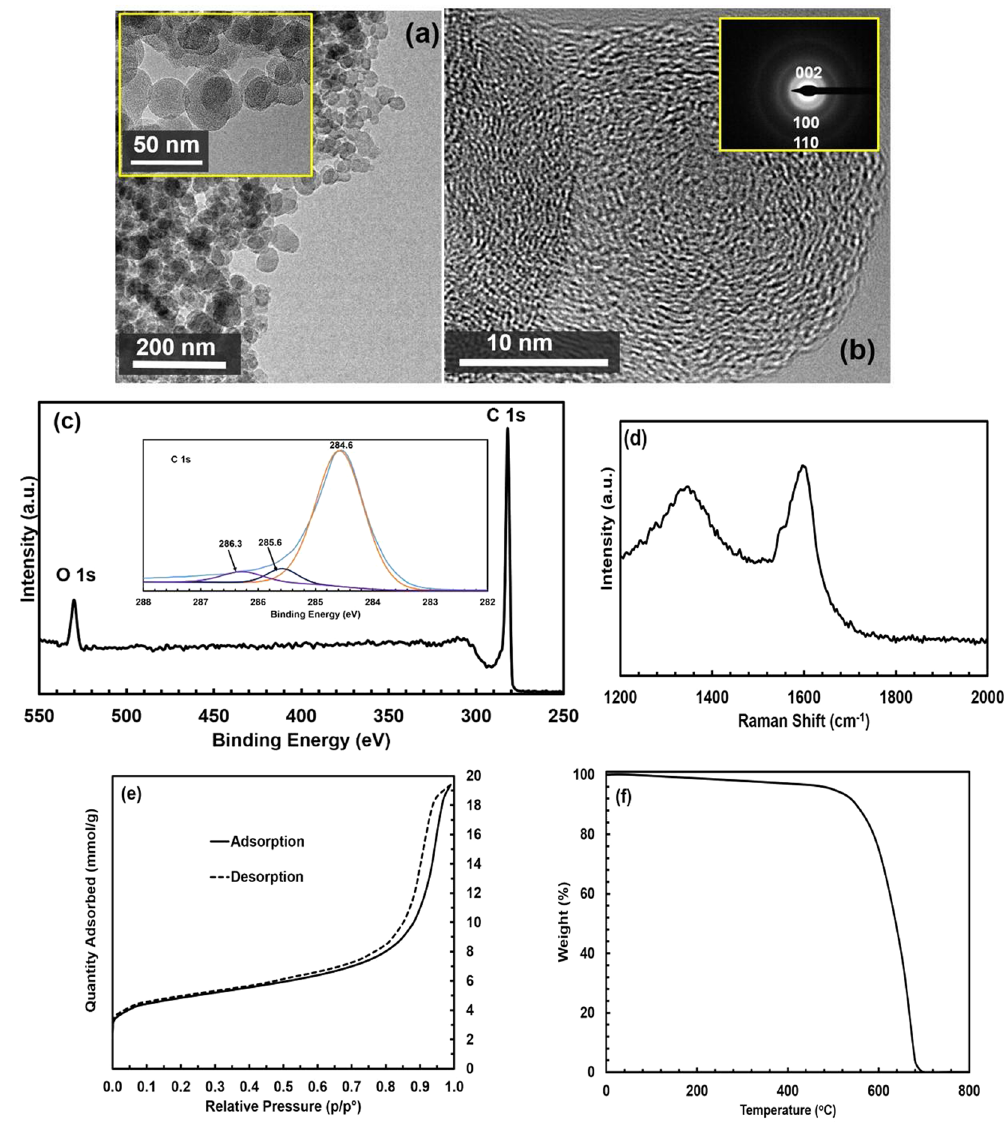
Figure 2. Characterization of the prepared Candle soot. ( a ) TEM images with higher magnification (inset): The candle soot dispersion consists of a large number of nanospheres in the size range of 20 to 50 nm ( b ) High resolution TEM image of the candle soot and its SAED pattern (inset). It indicates the presence of few pieces of crystalline carbon nanospheres in candle soot along with amorphous carbon, which is further confirmed by Selected Area Electron ( c ) XPS spectrum. It indicates that the candle soot consists mostly of carbon nanoparticles. The inset in the figure shows the deconvolution of C1s XPS peak ( d ) Raman shift of the candle soot. The peak at 1350 cm − 1 (D bands) accounts for the amorphous carbon and the one at 1580 cm − 1 (G bands) corresponds to E 2g mode of graphite due to the vibration of sp 2 -bonded carbon atoms in a 2D hexagonal lattice ( e ) Surface Area analysis of the candle soot. It is mesoporous material with an average pore size of 7 nm and a BET surface area of 366 m 2 g − 1 . ( f ) Thermogravimetric analysis of the candle soot, which shows the weight loss of the candle soot, is less than 3.5% up to the temperature of 450